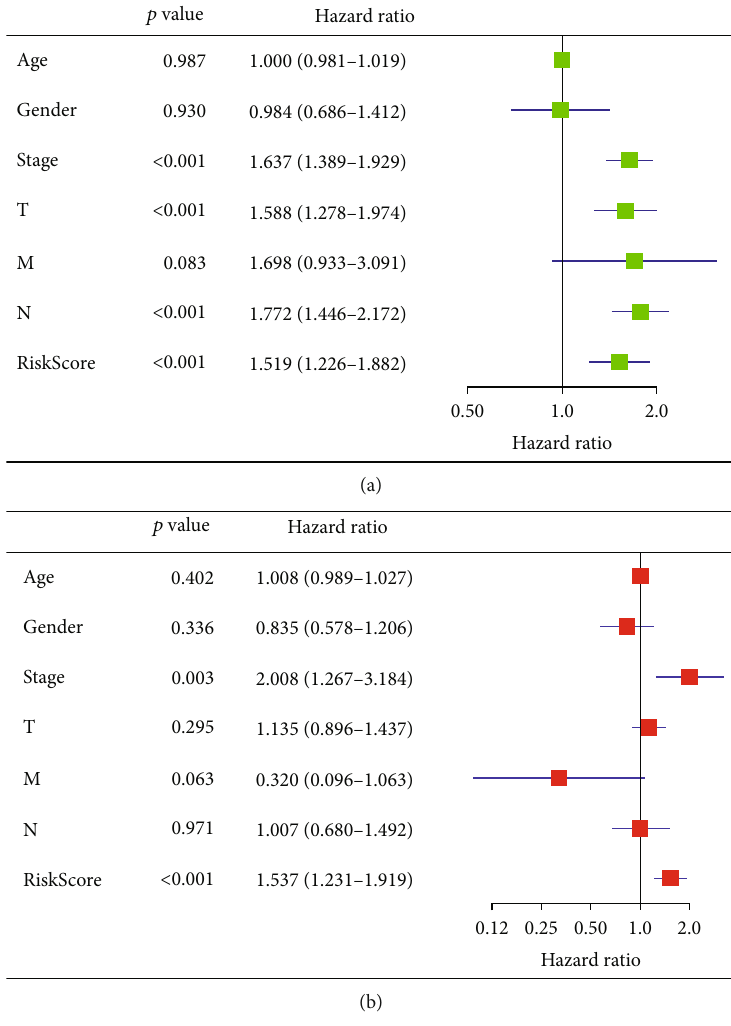
Figure 9: Univariate and multivariate Cox regression of risk score and clinical traits. (a) Univariate Cox regression. (b) Multivariate Cox